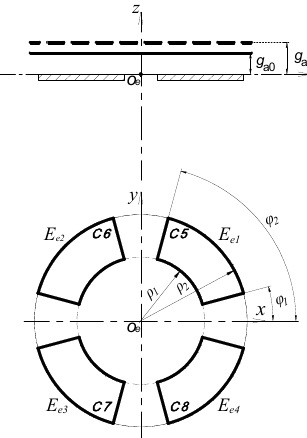
Figure 4. The calculation model of the axial error motion.